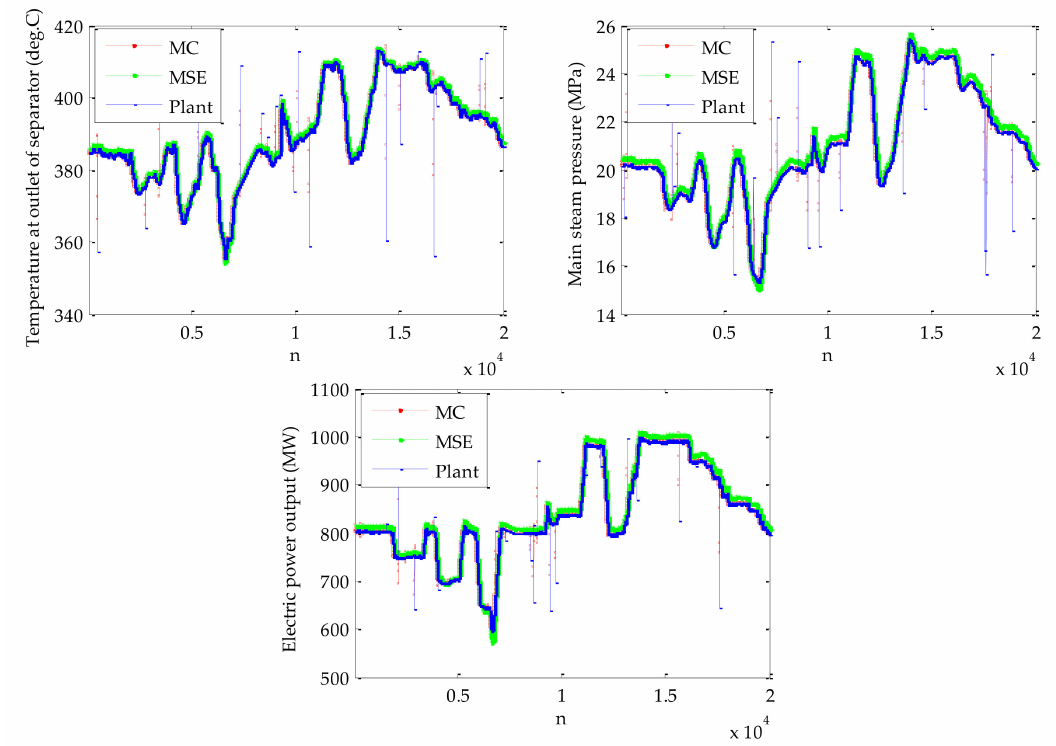
Figure 11. A comparison of SAE models using di ff erent loss functions without the preprocessing process